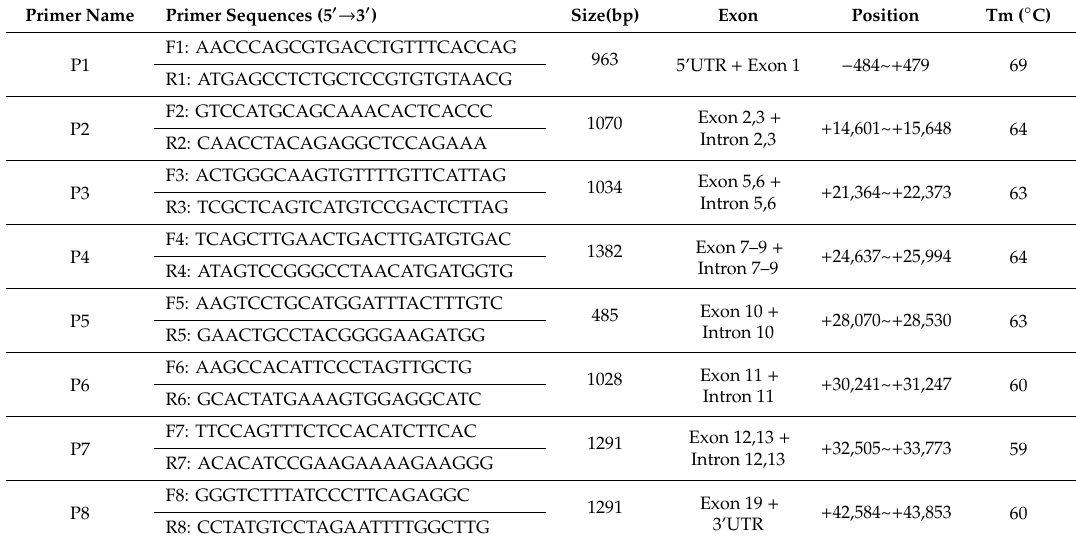
Table 1. Primer information of PCR amplification for long-chain acyl-CoA synthetase 1 ( ACSL1 ) genes. Primer